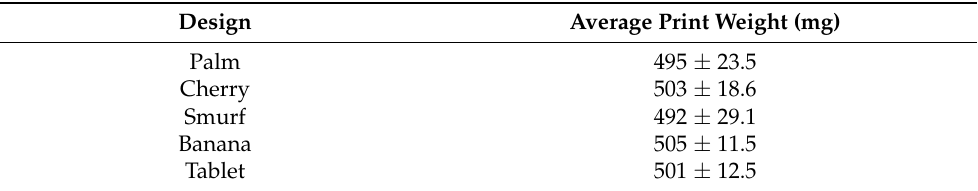
Table 1. Weight variation of the 3D printed fruit chew deigns.